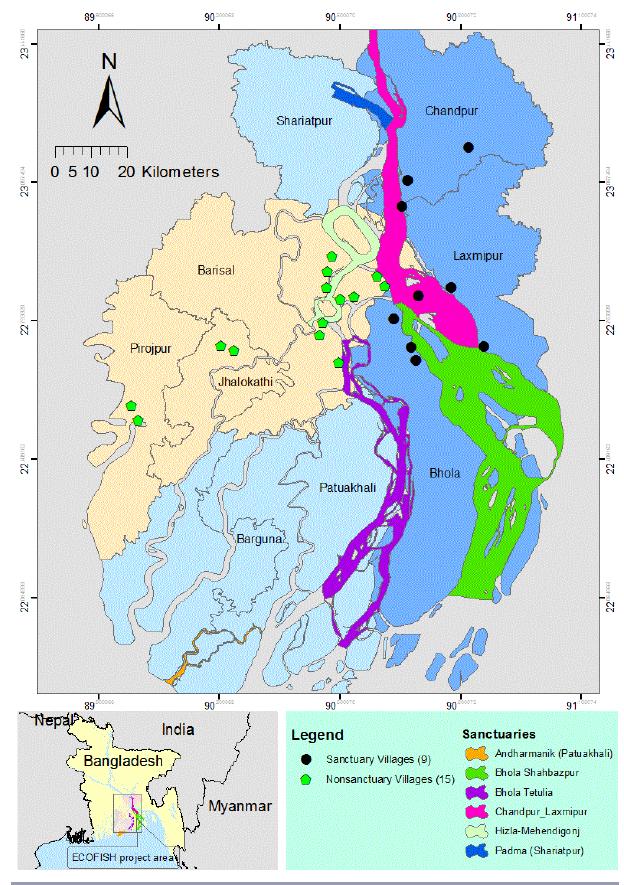
Fig. 1. Map of the study area covering the Meghna River and estuarine ecosystem, southern Bangladesh, with locations of surveyed hilsa fishing villages within sanctuaries and outside